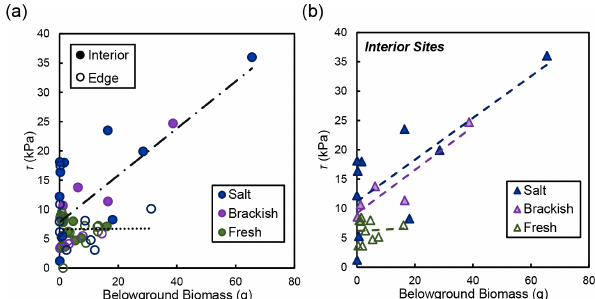
Figure 5. (a) Shear strength ( τ ) compared to live belowground biomass for the edge (open circles) and the interior (closed circles) locations, broken down by salinity type (salt refers to the Goodwin Islands and Catlett Islands locations, brackish refers to the Taski- nas Creek location, and fresh refers to the Sweet Hall Marsh and the Pamunkey Indian Reservation locations). Each point represents a biomass measurement with its associated shear strength value at concurrent depths in the soil profile. Only the relationship between belowground biomass and shear strength in the interior was sig- nificant ( R 2 = 0 . 58; p = 1 . 09 × 10 − 5 ). (b) Relationships between belowground biomass and shear strength ( τ ) from panel (a) for in- terior sites only, broken down by salinity type (same as a ). Only the relationships between salt ( R 2 = 0 . 57; p = 0 . 012) and brackish ( R 2 = 0 . 86; p = 0 . 025) sites were